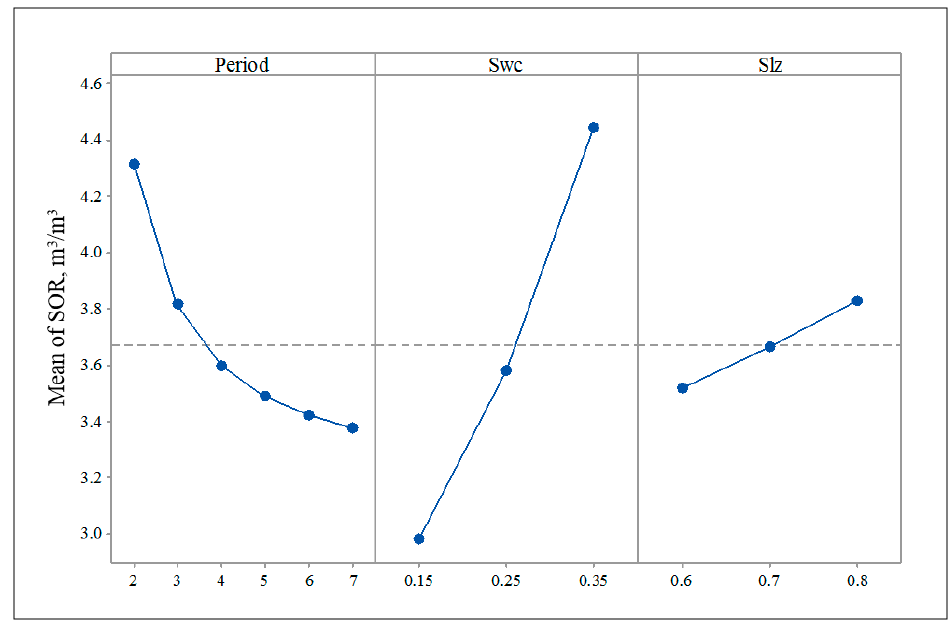
Figure 6. Main effect analysis for SOR.